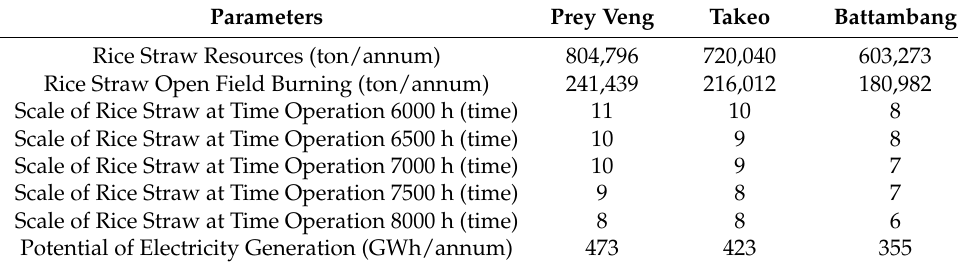
Table 9. Rice straw resources and electricity generation in case study area.